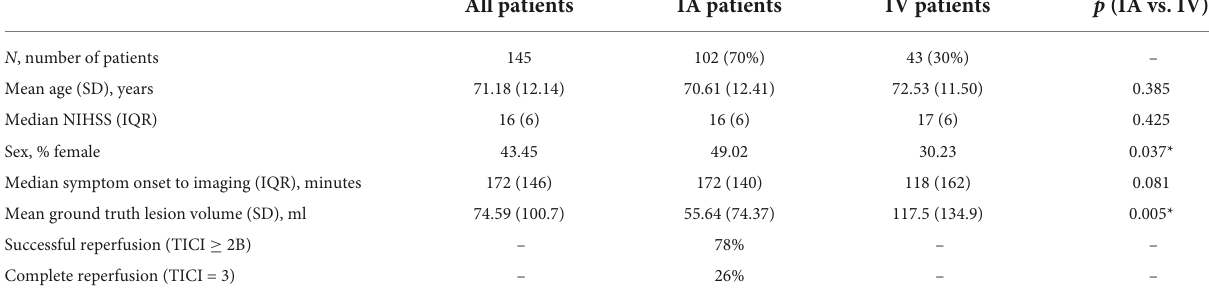
TABLE 1 Patient